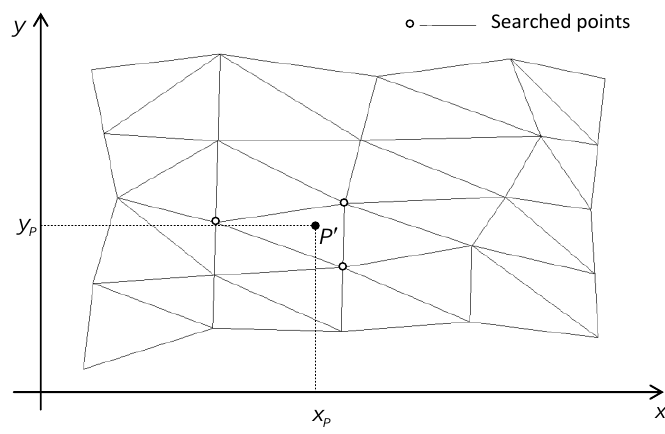
Figure 7. Projection of the road surface area on the xy plane.